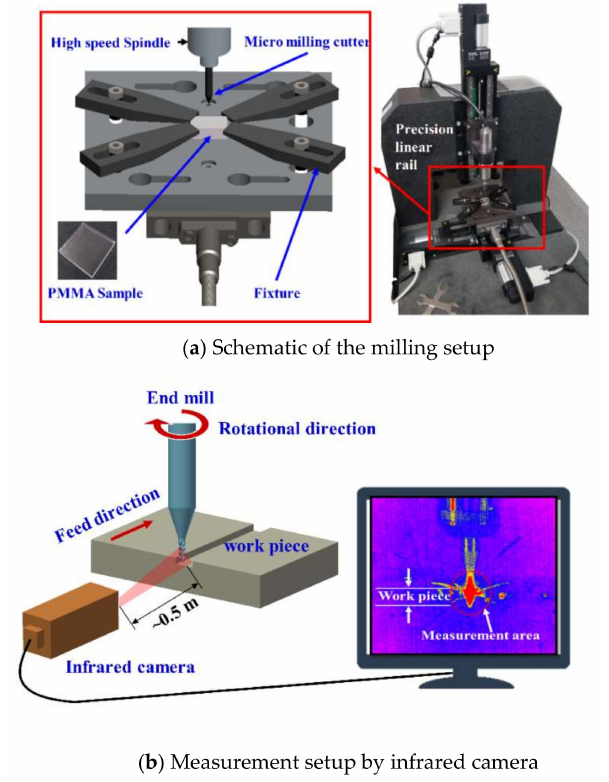
Figure 1. Sample and schematic of the experimental